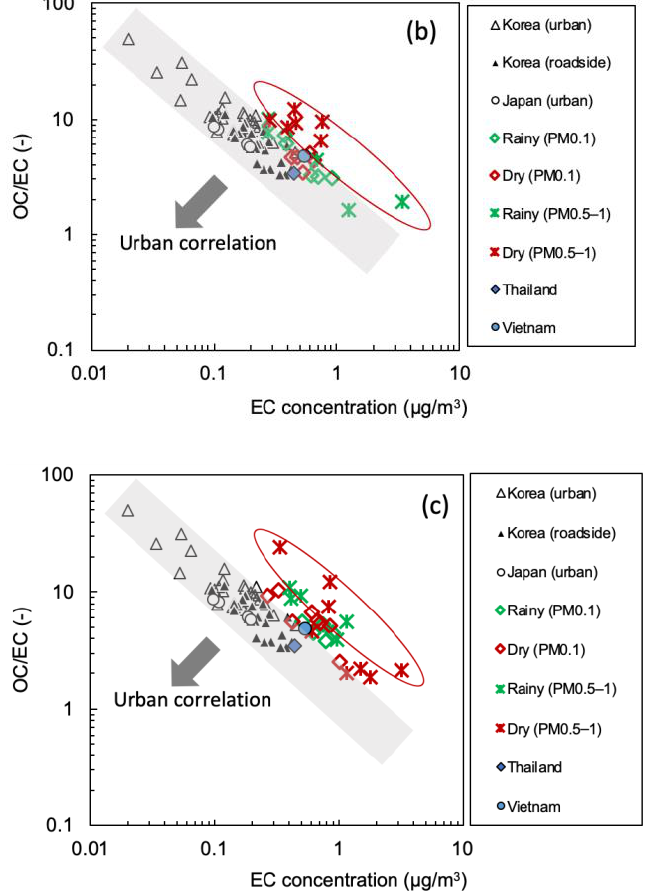
Figure 7. Comparison of OC/EC ratio to mass concentration of EC in the PM 0.1 and PM 0.5–1 in East Asia: ( a ) Padang, ( b ) Jambi, and ( c ) Pekanbaru.